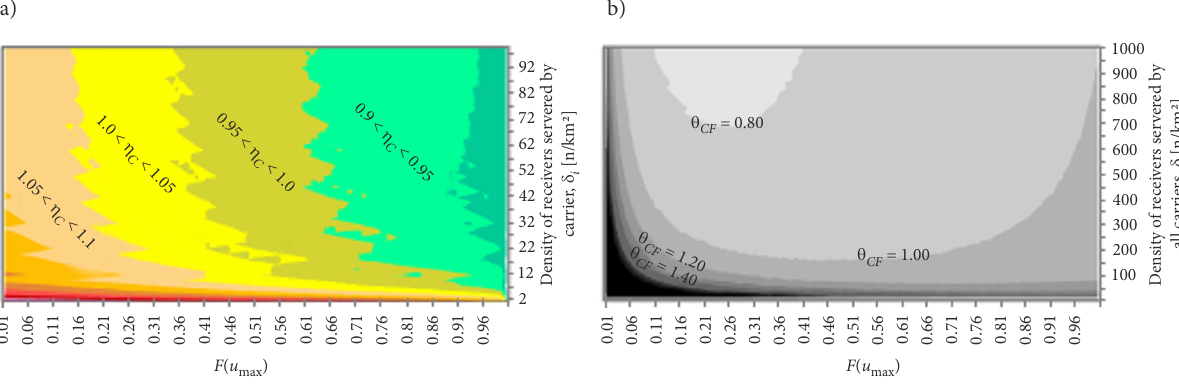
Figure 5. Results in Scenario 2.1 ( C CF = 9 m 3 ) with MinFare criterion: a – h C ratio; b – fare q CF [€]